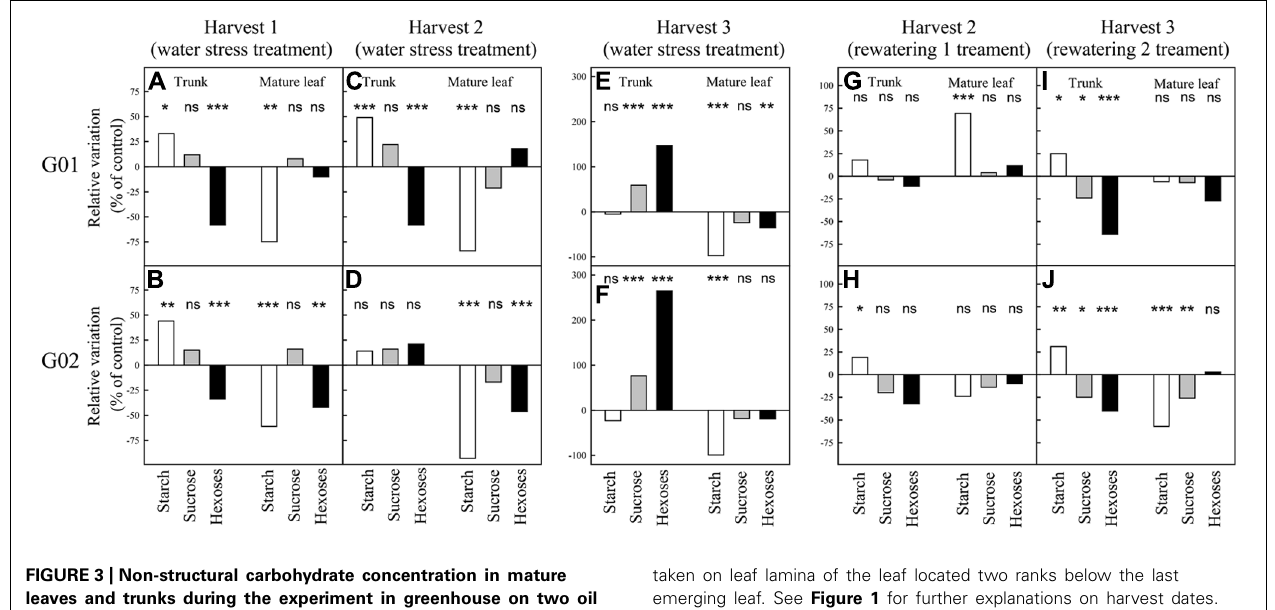
FIGURE 3 | Non-structural carbohydrate concentration in mature leaves and trunks during the experiment in greenhouse on two oil palm genotypes (G01 and G02). Each bar represents the relative variation in NSC concentrations of water stressed (or rewatered) vs control plants. The samples for “mature leaf” correspond to the samples